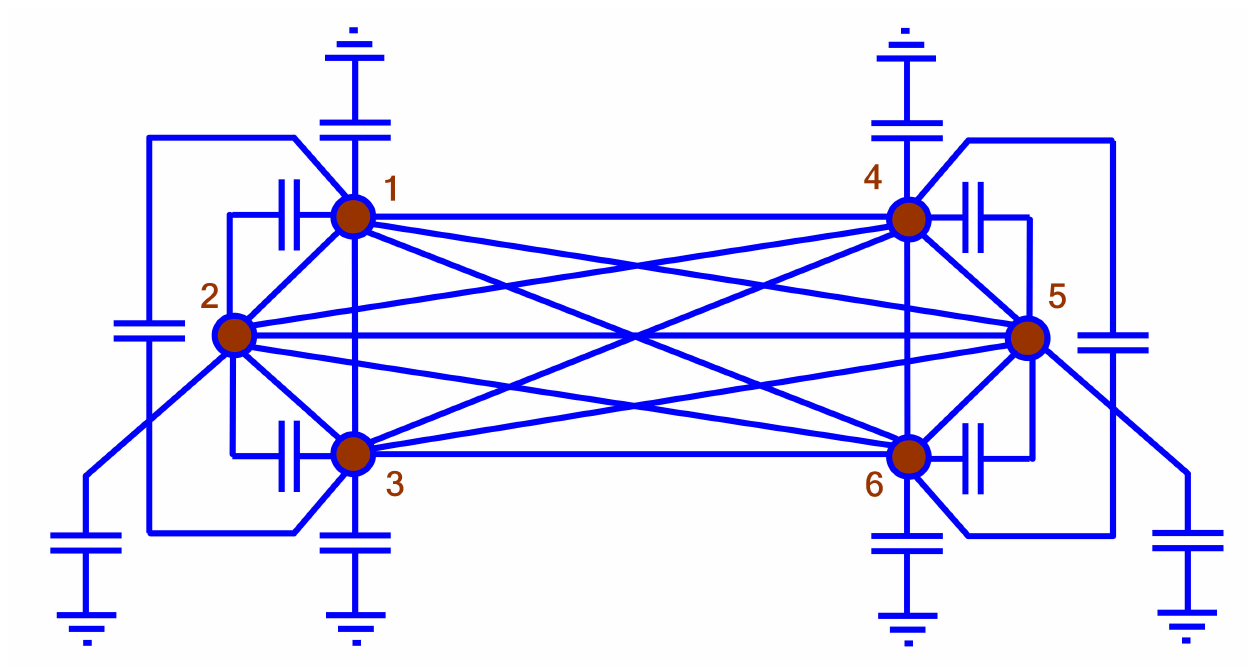
Figure 6. Lattice circuit of a three-wire power line, taking into account capacitive susceptance.